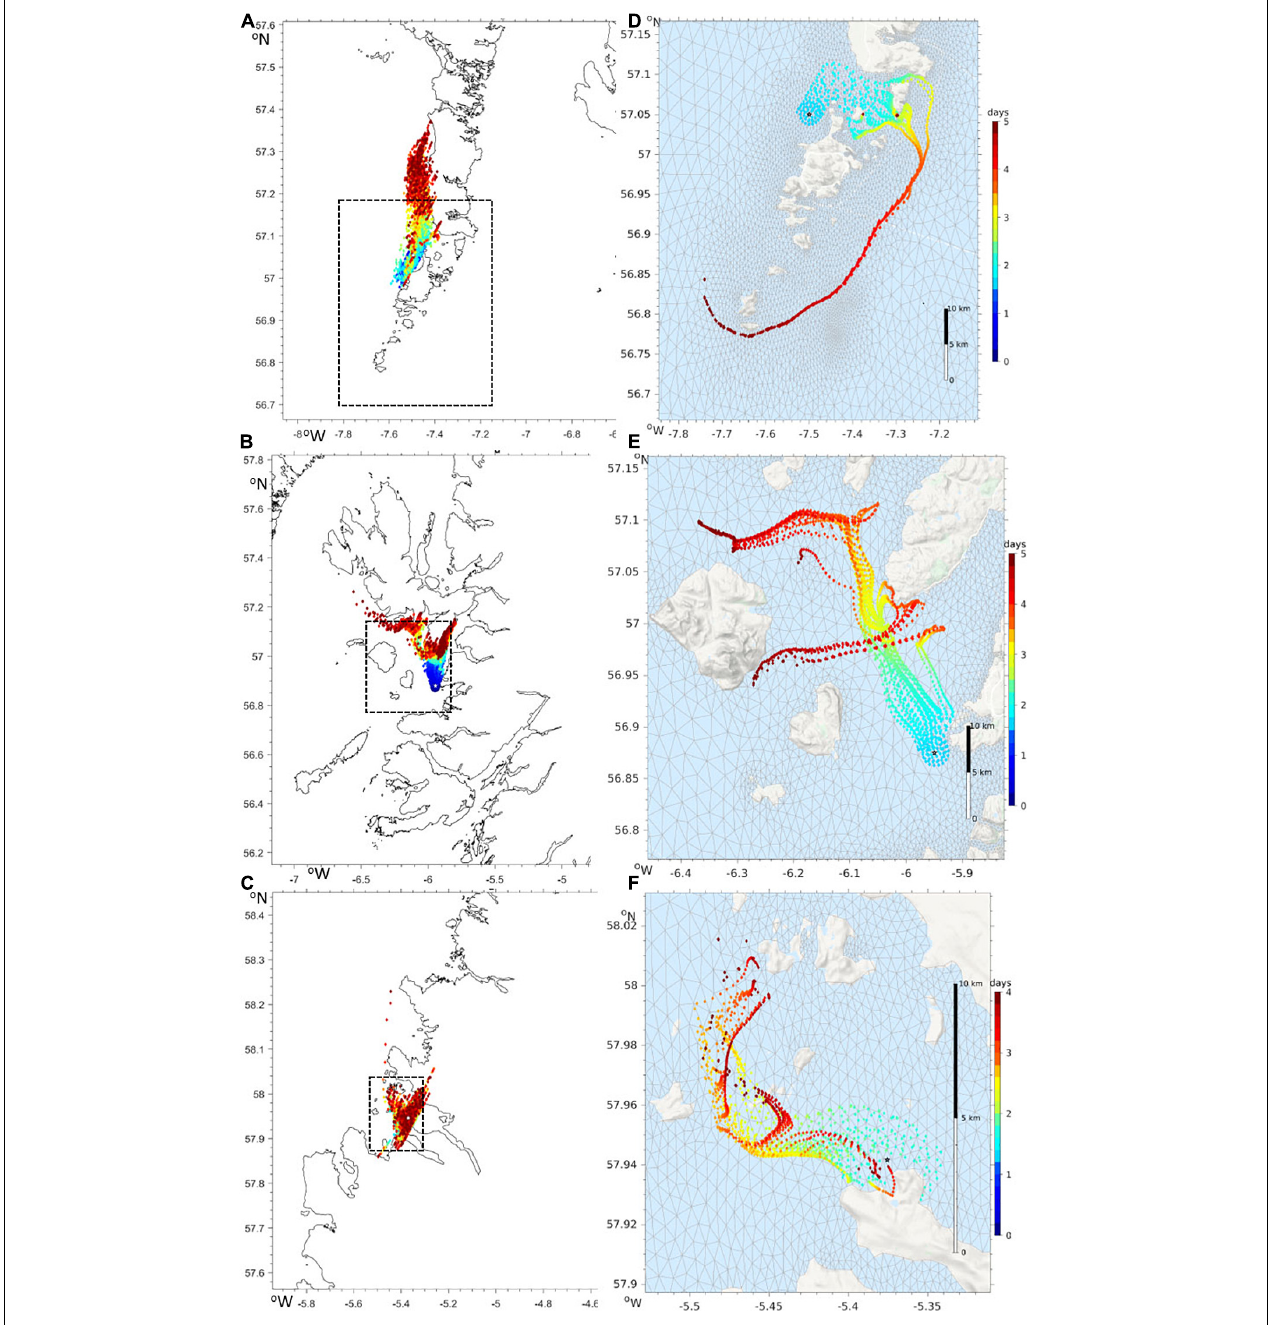
FIGURE 9 | Advection of virtual particles driven by surface currents in the Mercator-IBI36 (A–C) and WeStCOMS-FVCOM (D–F) hydrodynamic models. The colours show the forecast over next 5 days since after noon of 2019/08/27. Modelled particles were launched from the locations with the highest abundances of Karenia-mikimotoi near the Isle of Barra (A,D) , on Arisaig (B,E) and in Loch Kinnaird (C,F) . The areas on the right hand WeStCOMS simulations are highlighted in the left-hand Mercator-IBI36 plots by a dashed rectangle.